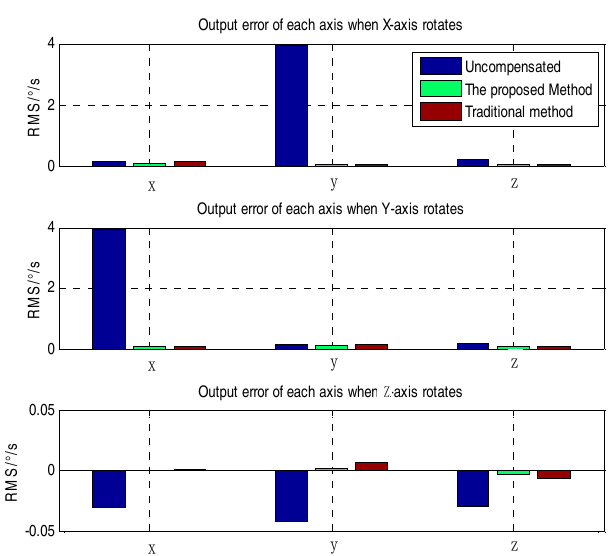
Figure 8. Error distribution of each axis (determined using the uncompensated, proposed, and traditional methods). ( a ) Error distribution when the X-axis rotates; ( b ) error distribution when the Y-axis rotates; ( c ) error distribution when the Z-axis rotates.